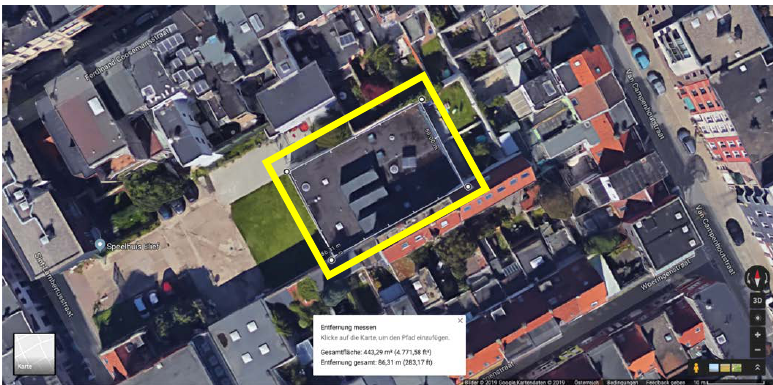
Figure 1. Mapping and project area of the Elief Playhouse in Antwerp / Belgium marked in yellow ( © google.com).